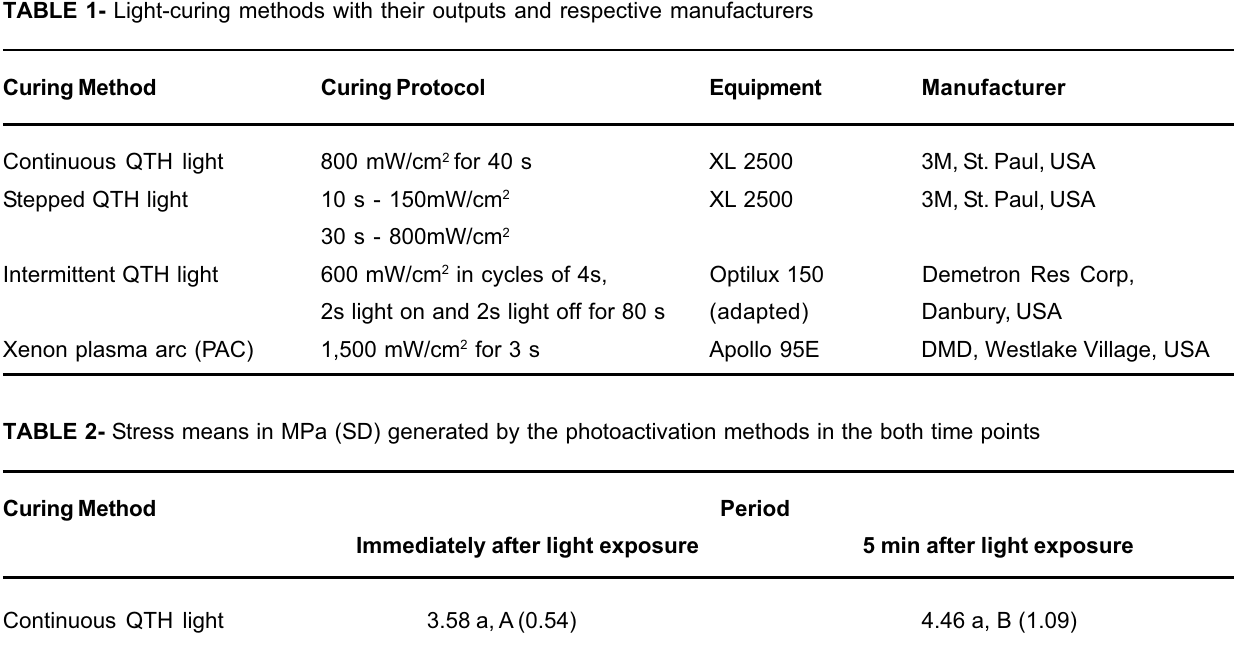
TABLE 1- Light-curing methods with their outputs and respective manufacturers